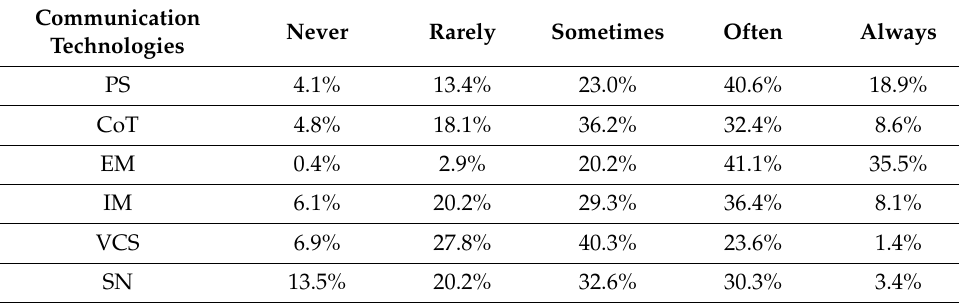
Table 19. Actual system usage of communication technologies by